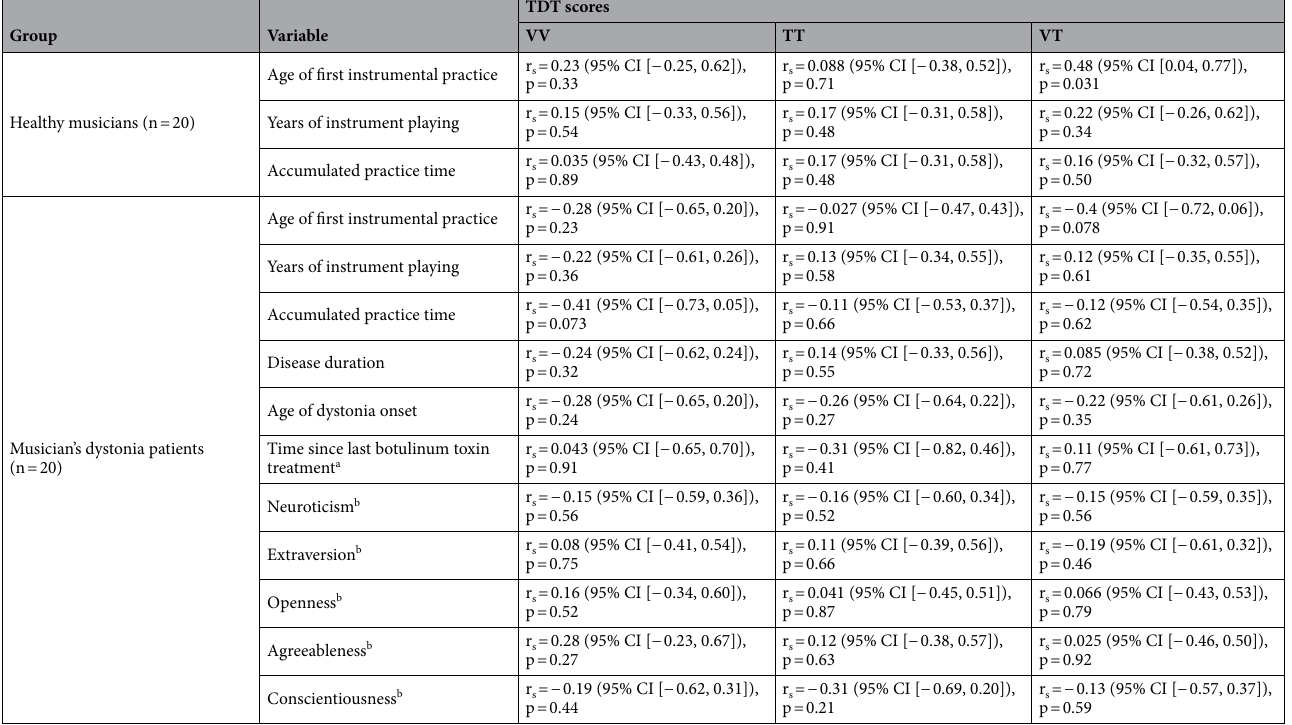
Table 2. Correlations between TDT scores and potentially influencing variables (musical activity variables, disease-related variables, NEO-FFI). r s = Spearman rank correlation coefficients. 95% confidence intervals in parentheses. Different TDT modalities are indicated as visual (VV), tactile (TT) and visual-tactile (VT). a Data from 11 patients currently receiving treatment with botulinum toxin. b Data from 18